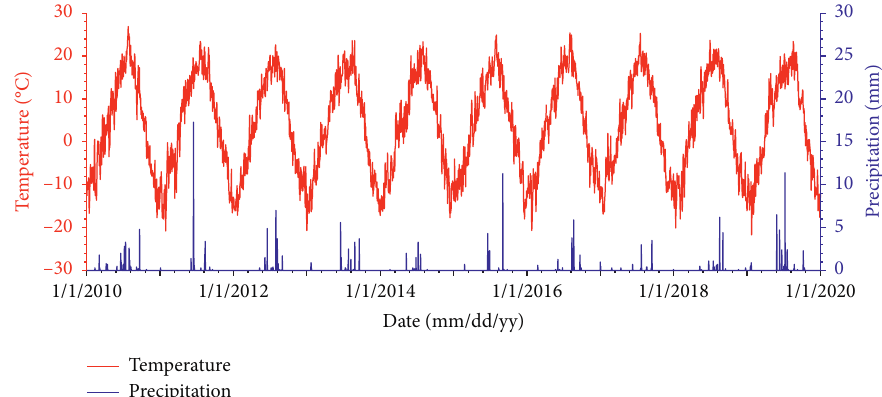
Figure 1: Observation of air temperature and precipitation in the study area monitored by Lenghu weather station.